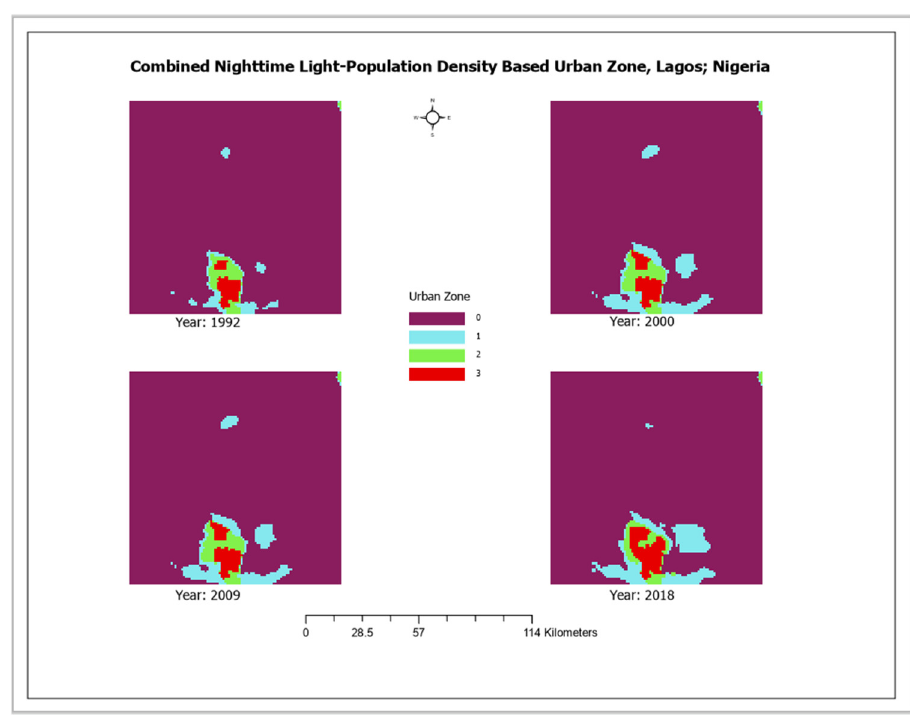
Figure 9. Combined nighttime light and population density-based zones.